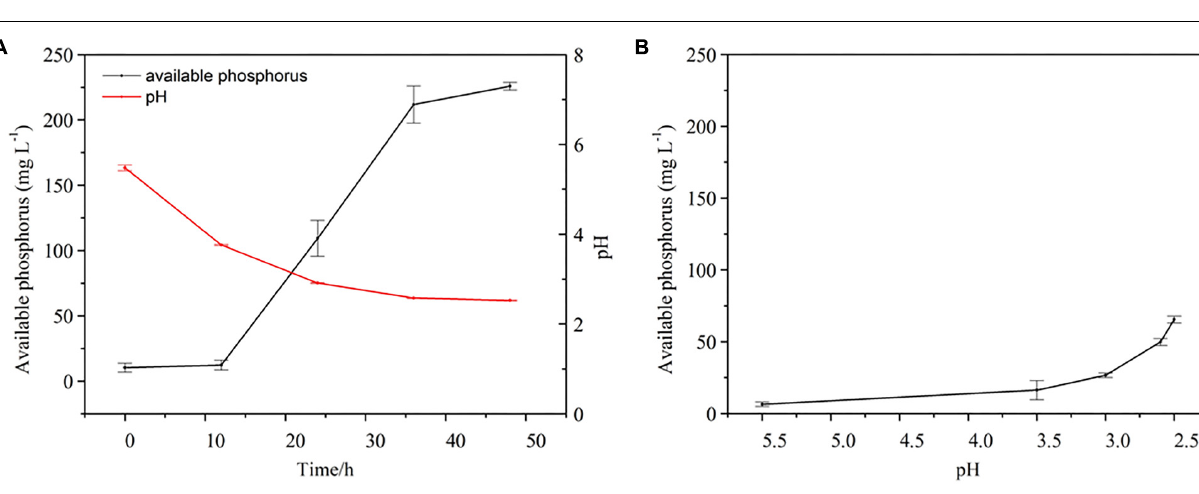
FIGURE 4 | Effect of pH on Al-P solubilization. (A) Available phosphorus concentration and pH of the culture medium after culturing Nguyenibacter sp. L1 with AlPO 4 as the P source at 30 ◦ C for 0, 12, 24, 36, and 48 h. (B) Available P concentration of the culture medium with AlPO 4 as the P source after manually adjusting the pH from 5.5 to 2.5 without inoculation with Nguyenibacter sp. L1. Vertical bars represent standard deviations of the means ( n =